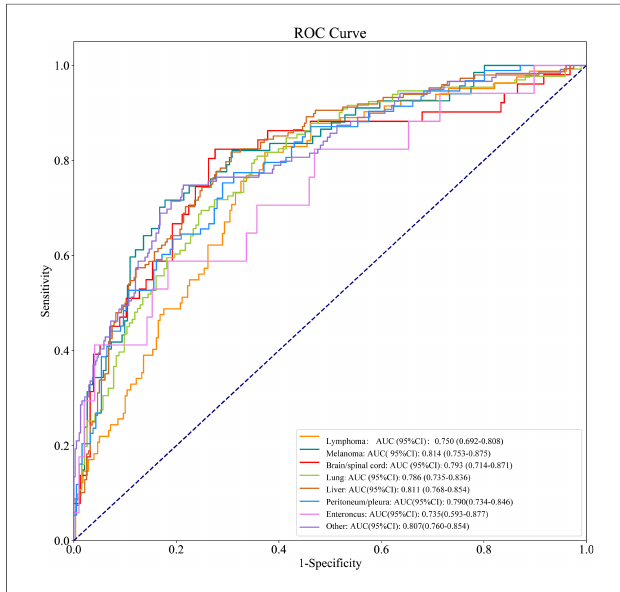
FIGURE 7 The nomogram for predicting the probabilityof death in patients with metastatic